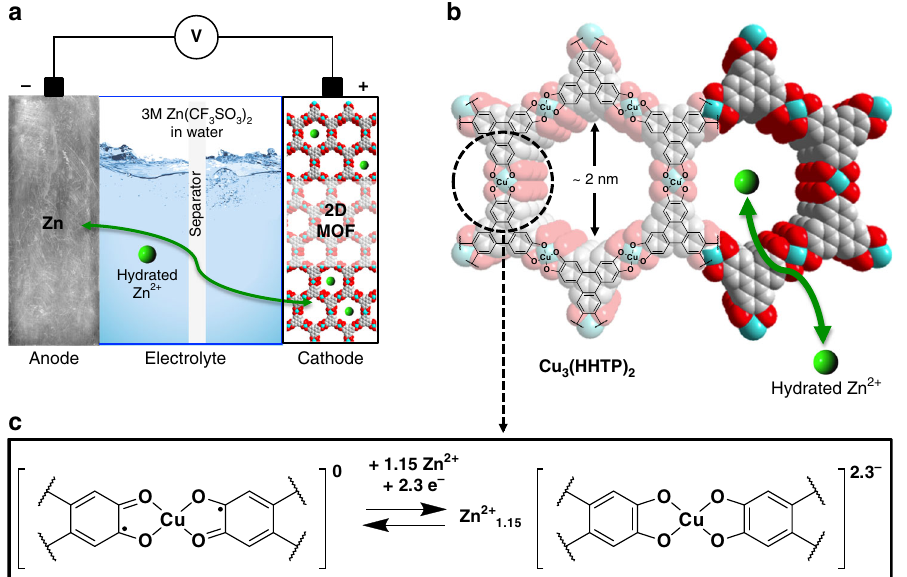
Fig. 1 Zn-Cu 3 (HHTP) 2 chemistry. a Schematic illustration of the rechargeable Zn-2D MOF cell. b Structure of Cu 3 (HHTP) 2 , which when viewed down the c axis, exhibits slipped-parallel stacking of 2D sheets with a honeycomb lattice. The cyan, red, and gray spheres represent Cu, O, and C atoms, respectively. The H atoms are omitted for the sake of clarity. c Expected redox process in the coordination unit of Cu 3 (HHTP)